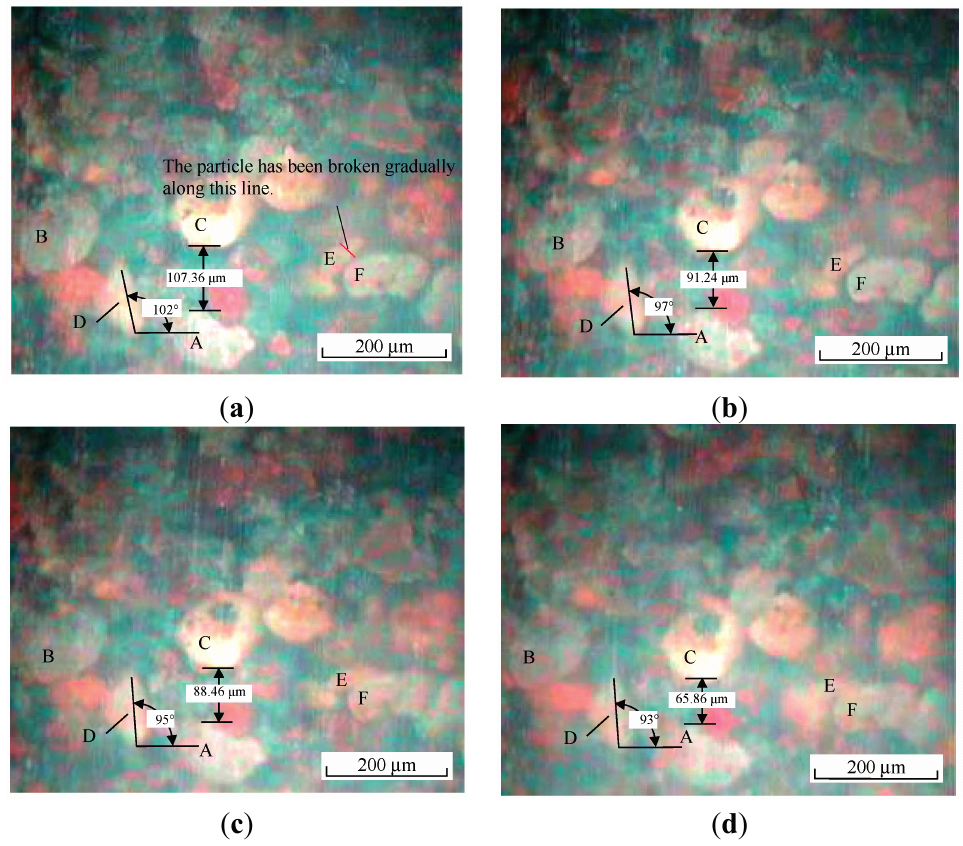
Figure 9. Micro-structure of Sample IV at different axial strains. ( a ) 2.5% axial strain;